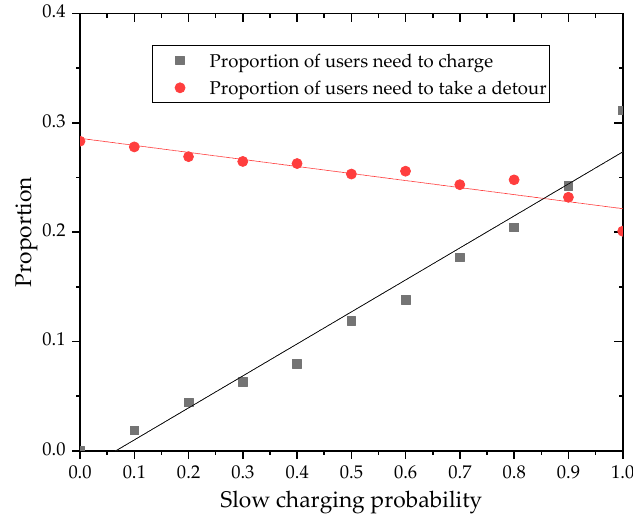
Figure 22. The influence on users under different slow charge probabilities.